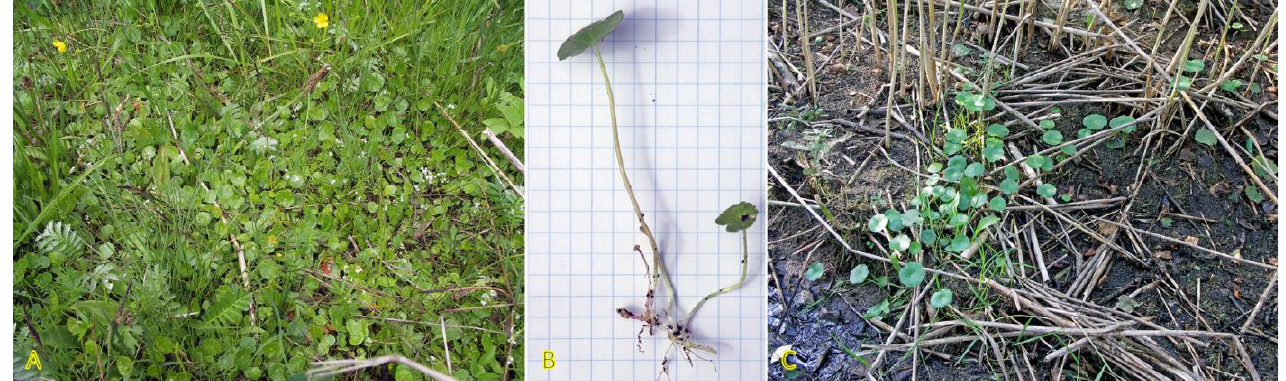
Figure 5. Hydrocotyle vulgaris plants dominating in a wet coastal meadow in Mērsrags, Latvia ( A ), the apical fragment of the shoot ( B ), foraging plant on the shore of Lake Būšnieks, near Ventspils, and Latvia ( C ).